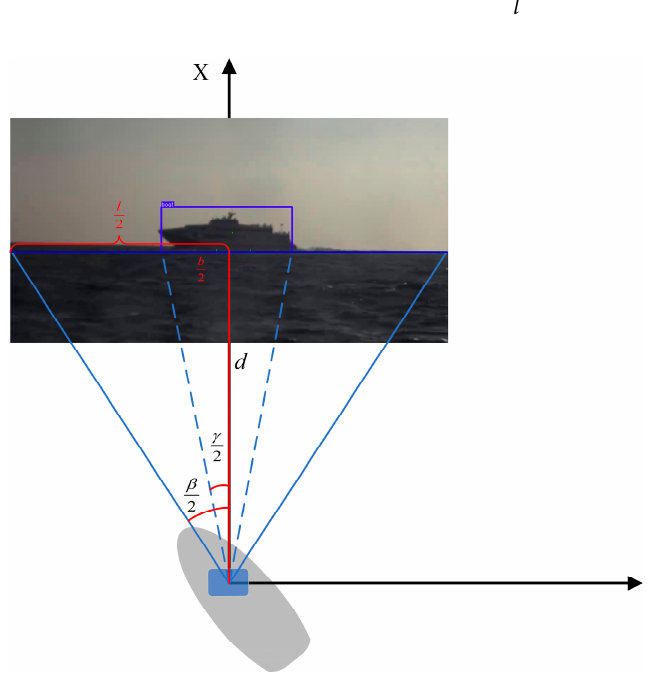
Figure 5. Schematic diagram of the USV’s field of view.